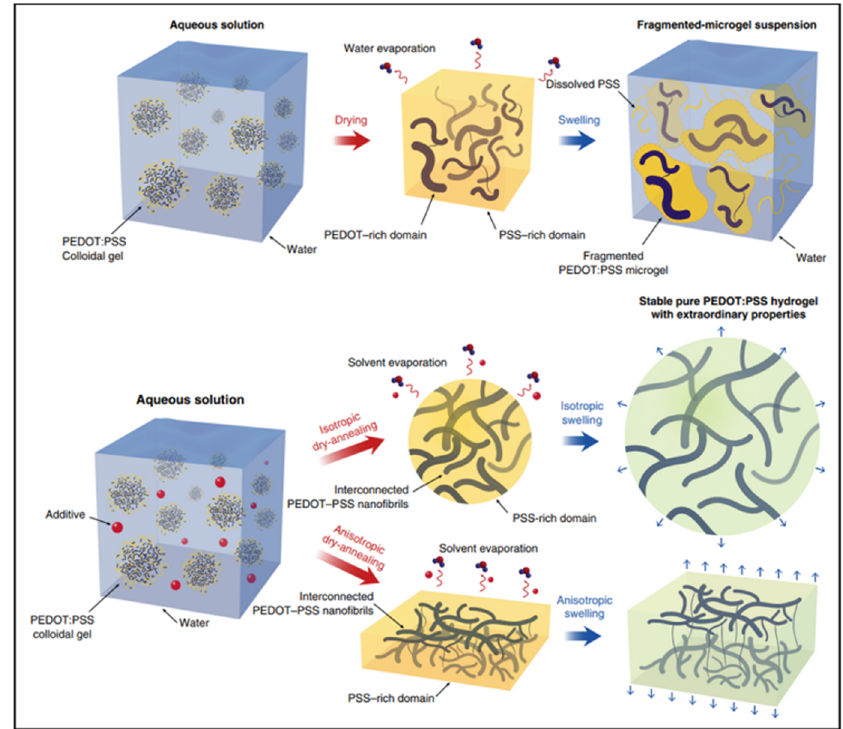
Figure 5. I. Typical drying and swelling processes of pristine PEDOT:PSS without DMSO. II. Dry-annealing and swelling processes of PEDOT:PSS with DMSO as the additive [30]. Reprinted with permission from Ref. [30]. Copyright© 2022, Springer Nature.